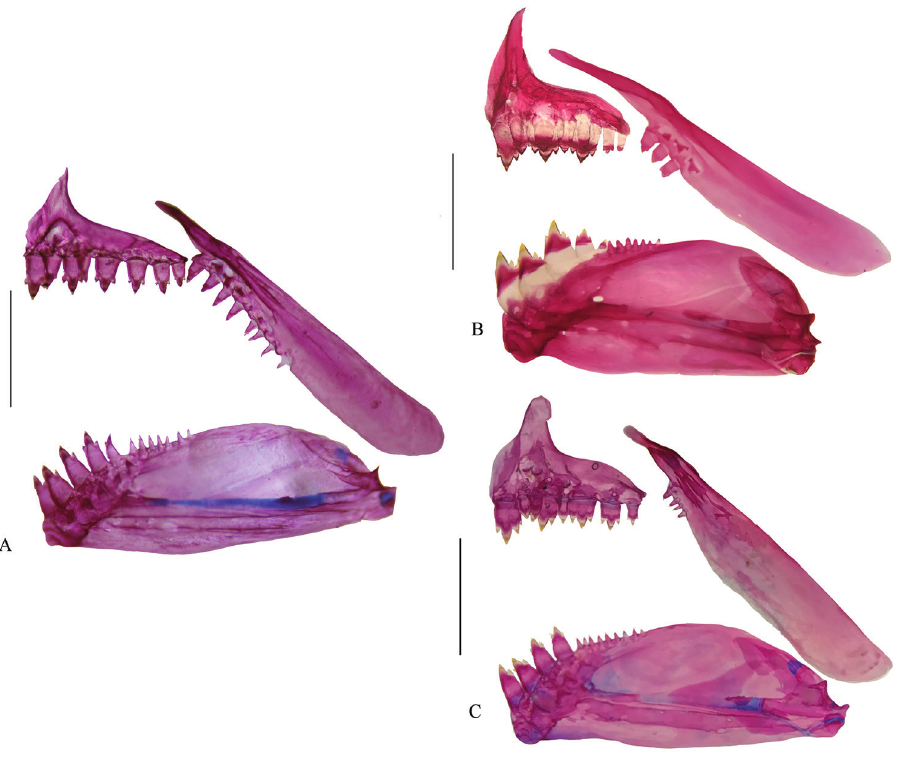
Figure 2. Upper and lower jaws of A Hyphessobrycon klausanni sp. n., UARC-IC 541, 20.2 mm SL B H. metae MCNG 32469, 19.9 mm SL and C H. acaciae , IUQ 2795 Paratypes, 28.6 mm SL. Scale bar: 1 mm.